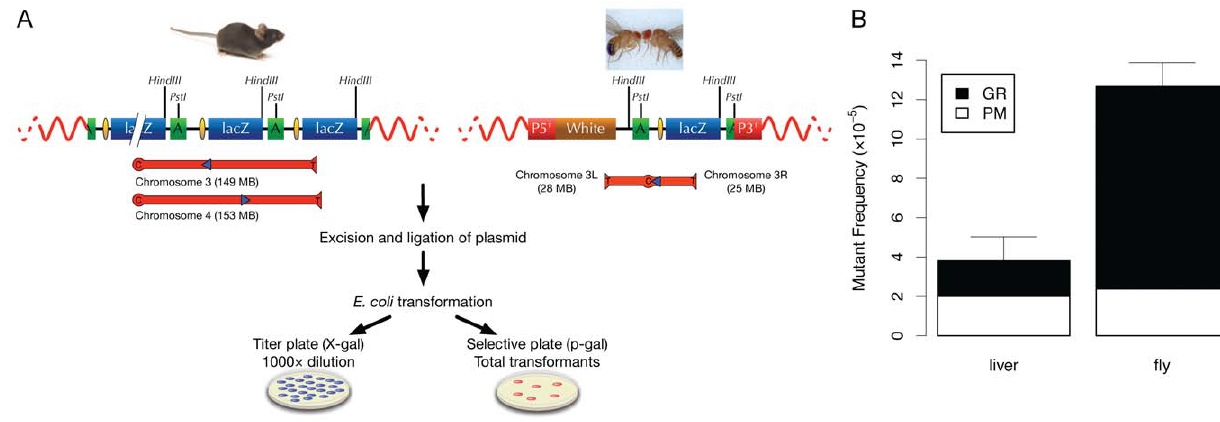
Figure 1. Comparative analysis of somatic mutations in mice and flies. (A) Schematic depiction of the LacZ-plasmid model in Mus musculus and D. melanogaster . Note that the mouse line 60 contains about 10 head-to-tail organized plasmid copies per integration site, but only two plasmid copies are depicted. For the transgenic flies, each line harbors only 1 copy of the pUR288 plasmid. Individual plasmids can be rescued by excision of genomic DNA with Hin d III (H) or Pst I (P). After purification from the mouse or fly genomic DNA, self-ligation and transformation into Escherichia coli C ( D lacZ , galE - ) host cells, individual plasmids are recovered in the form of ampicillin-resistant colonies. A small amount of transformants is plated on medium containing X-gal, to determine the total number of plasmids rescued (titer plate). The remainder is plated on media supplemented with the lactose-analogue p-gal, to select only the cells harboring a mutant lacZ (selective plate). The mutant frequency is the ratio of the colonies on the selective plate versus colonies on the titer plate (times the dilution factor). Location and direction of the integration site of the pP[CaSper]vector is shown for line 11. For the mouse, the location and direction of the integrated pUR288 concatamers is shown for line 60. Lac Z= lacZ reporter gene; P5 9 =5 9 end of (pP[CaSper]); P3 9 =3 9 end of (pP[CaSper]); white= the white selection marker. (B) Direct comparison of spontaneous somatic mutation frequency in mice (3-month old; liver) and flies (1–2-days old; whole body). White bars represent the frequency of point mutations and black bars the frequency of DNA rearrangements. The frequency of all mutations in the fly is greater than that of mouse liver (one-tailed Welch Two Sample t-test, p=9.04e 2 05). Error bars are Standard Deviations.